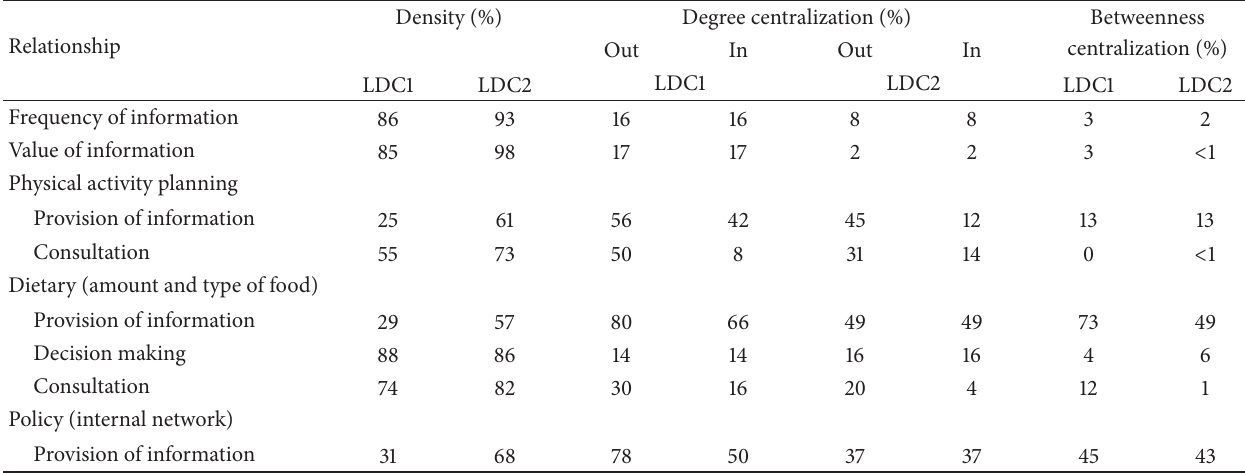
Table 1: Density and centralization scores for each